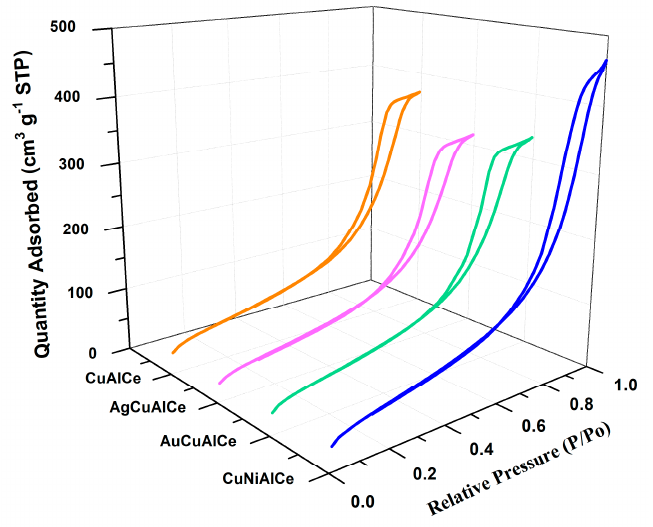
Figure 1. Adsorption–desorption isotherms for monometallic CuAlCe and bimetallic AgCuAlCe, AuCuAlCe and NiCuAlCe catalysts.